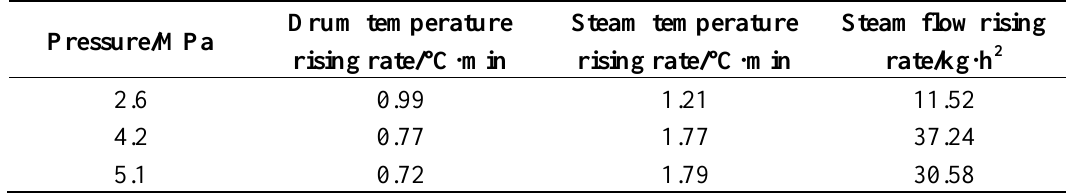
Table 1. Maximum rising rate of the control variables during start-up